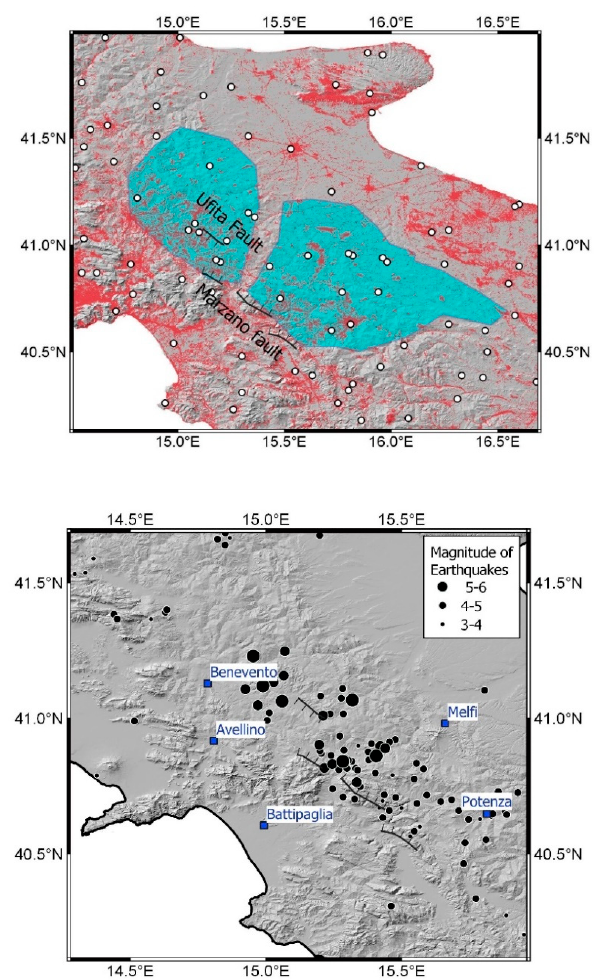
Figure 2. ( Top ) Map of the distribution of persistent scatterers (PS) (red points) and the GNSS permanent stations (white points) involved in the detection of ground surface movements of the study area. The main geodynamic features are represented in the background of the map: the Irpinian Dome is the cyan area and the Ufita and Marzano faults are represented with black hashed lines. ( Bottom ) Map of the main seismic events (black circles) that occurred from 1466 to 2017 with the main towns highlighted (dark blue squares).